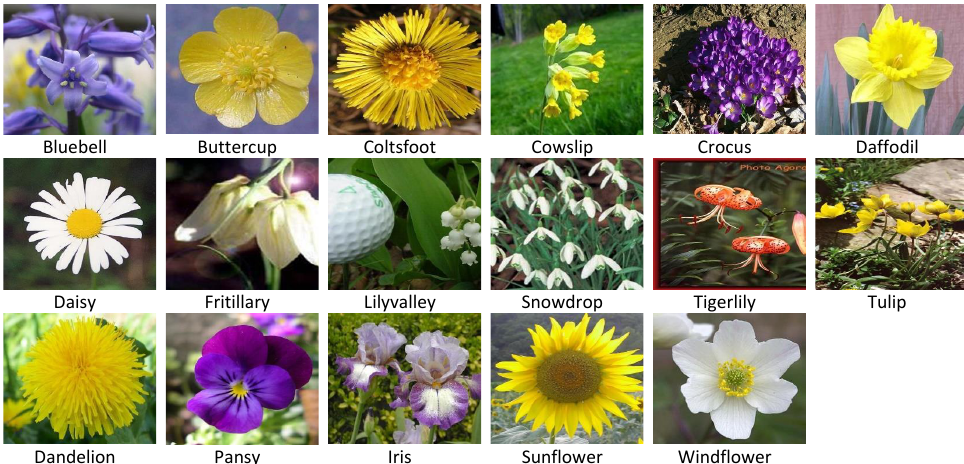
Figure 8. Sample image of each semantic category of the Caltech-10 dataset.